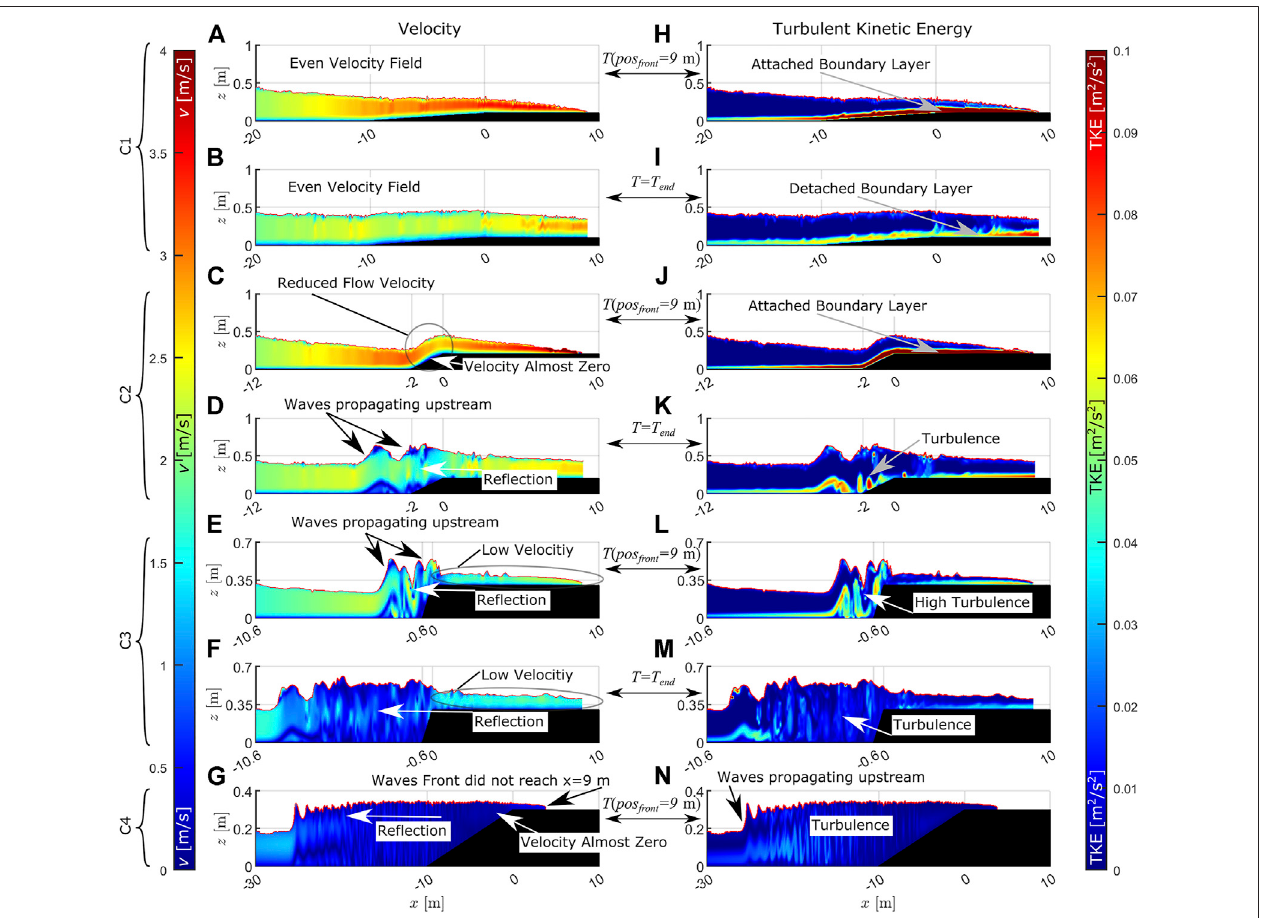
FIGURE7| Velocity fi elds(leftcolumn)andturbulentkineticenergy(rightcolumns)ofclassesC1 – C4(indicatedbybracketsontheleft)attwoinstantsintime(upper and lower row of each class) of class C1 (A,B,H,I) , class C2 (C,D,J,K) , class C3 (E,F,L,M) , and class C4 (G,N) . Velocities are given in bolt and the turbulent kinetic energy in m 2 / s 2 . The composite bathymetry is indicated as a black